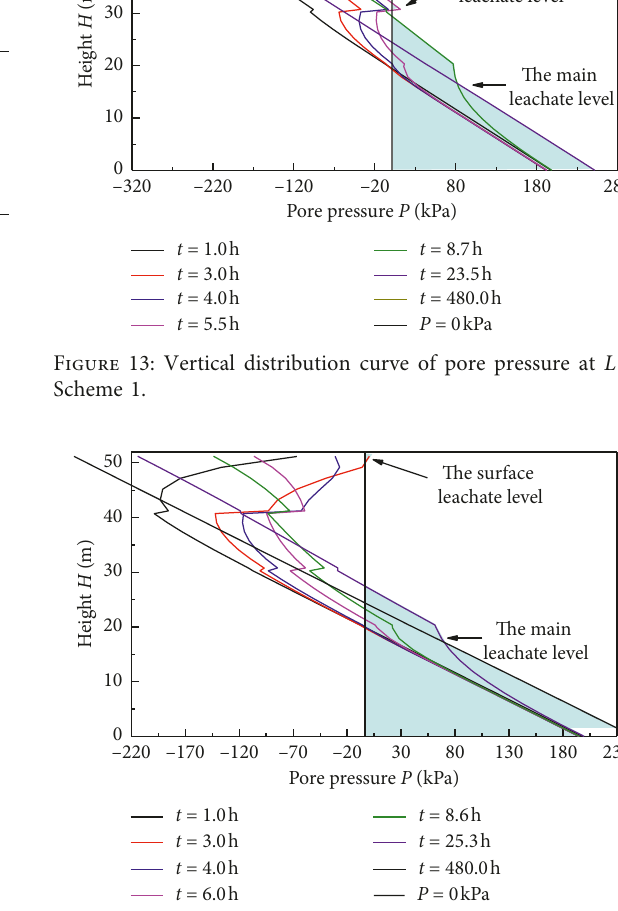
Figure 14: Vertical distribution curve of pore pressure at L 1 in Scheme